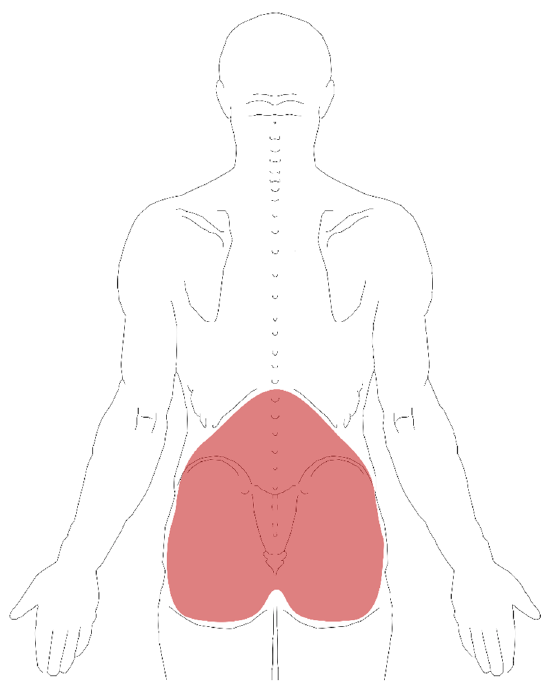
Figure 1. Low back pain map.